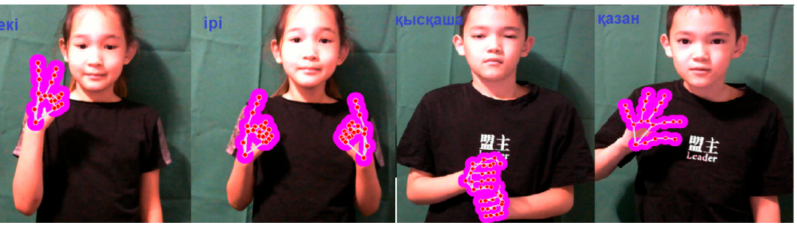
Figure 4. Example of static